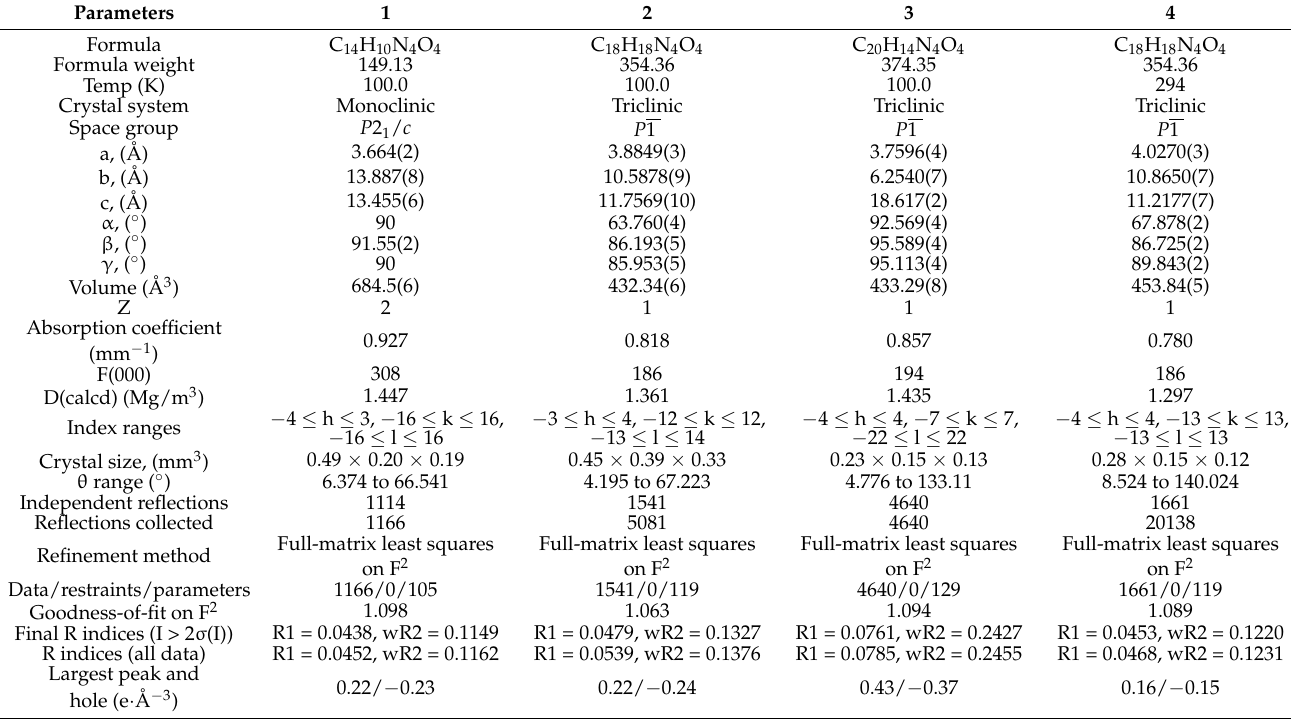
Table 1. Crystallographic data and structure refinement details for co-crystals 1 – 4